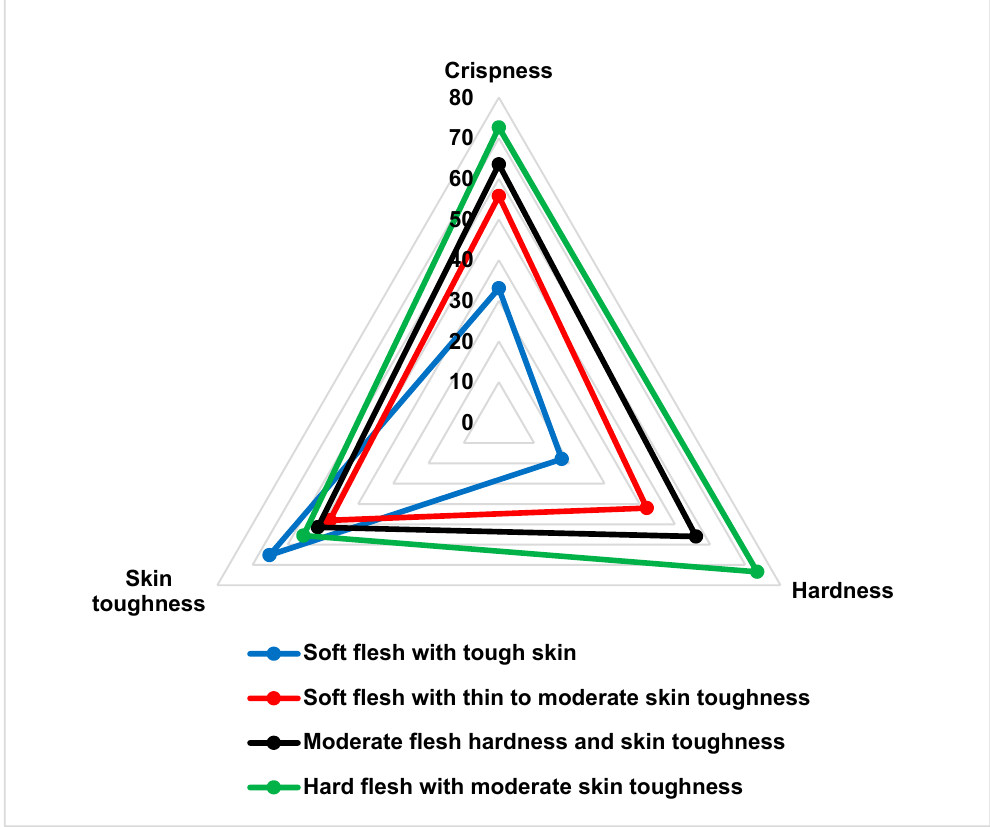
Figure 3. Sensory textural profile showing the mean scores ( n = 72) for the four apple textural groups, which were identified by PCA and validated by linear discriminant analyses, with the five selected TA.XT plus parameters.